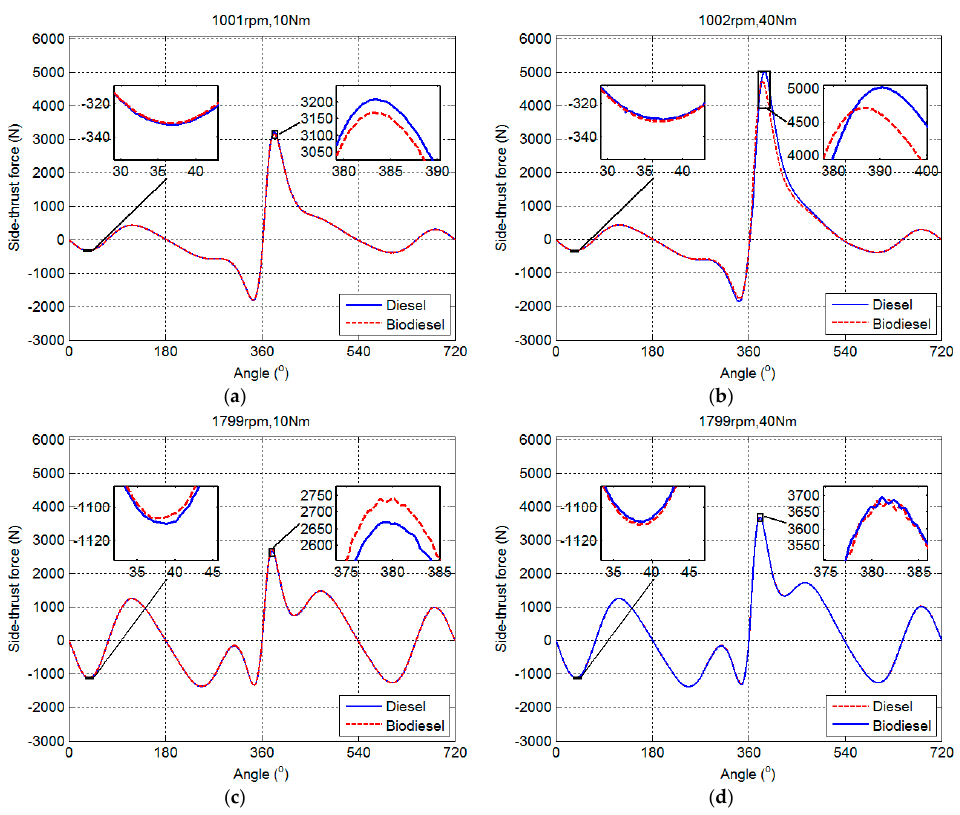
Figure 9. Piston side-thrust forces of alternative fuels under different operating conditions: 1000 rpm and 10 Nm; ( b ) 1000 rpm and 40 Nm; ( c ) 1800 rpm and 10 Nm; ( d ) 800 rpm and 40 Nm.